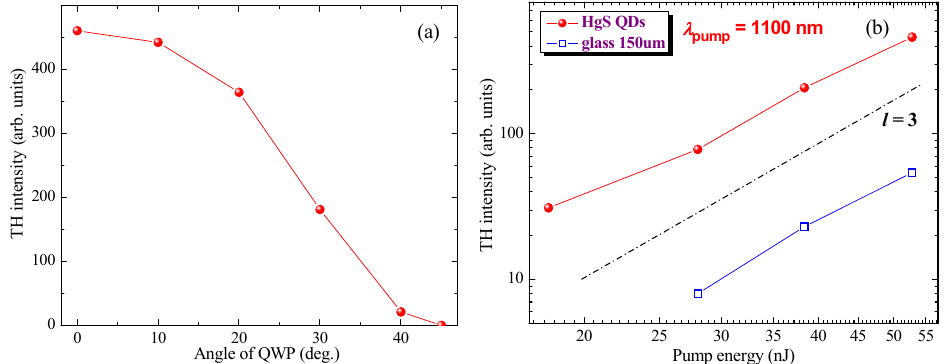
Figure 8. ( a ) The dependence of TH yield on the angle of quarter-wave plate (QWP). ( b ) Dependence of harmonic yield on the pulse energy. Reprinted with permission from Ref. [31], 2022, MDPI. The spectral dependence of TH yield was analyzed by tuning the wavelength of PP in the 900–1700 nm range (Figure 9). The ratio of TH yields from the film + plate and pure plate are presented in the upper panel of this figure. The maximal ratio was achieved at the 1100 nm wavelength of